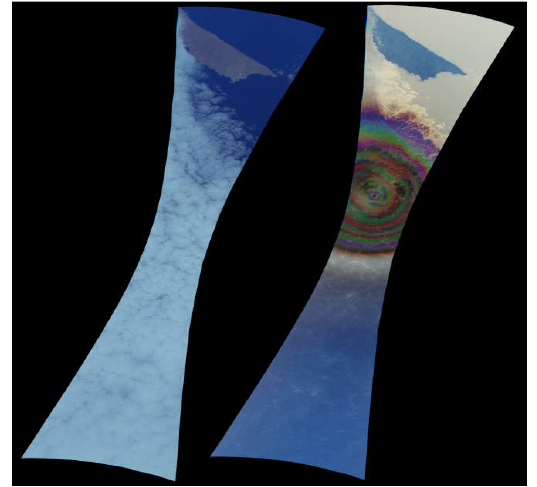
Figure 6. AirMSPI intensity (left) and DOLP (right) imagery acquired during a “continuous sweep” sequence on August 31, 2011 off the coast of California. Figure 6 is an example set of AirMSPI images acquired during a flight off the coast of Southern California on August 31, 2011. These images are from one pushbroom slew acquired during a “continuous sweep” sequence as the ER-2 was flying northward. The bowtie shape is due to the increase in linear swath width as the camera points off-nadir. The left image is a “true” color intensity view showing a field of stratocumulus clouds, with San Clemente Island near the top of the scan. The right-hand image is the same scene in polarized light, and is a color composite of DOLP at 470, 660, and 865 nm. Several notable features are apparent in the polarized view that are invisible in intensity. The circular colored fringes are so-called supernumerary bows, or interference fringes resulting from different optical paths of light at different wavelengths through the spherical cloud droplets. At the center of the rings is the backscatter direction (scattering angle = 180º) where the direction to the Sun is directly opposite the direction of view. This is where the scattering feature known as the glory is found. Surrounding the colored rings is a bright, white region where DOLP is relatively high and spectrally neutral. This feature occurs at a scattering angle near 145º, and is known as the cloudbow. The detailed spacing of the supernumerary arcs is related to the droplet size distribution of the cloud particles. This image pair is an example of the type of information about particle microphysics contained in polarimetric